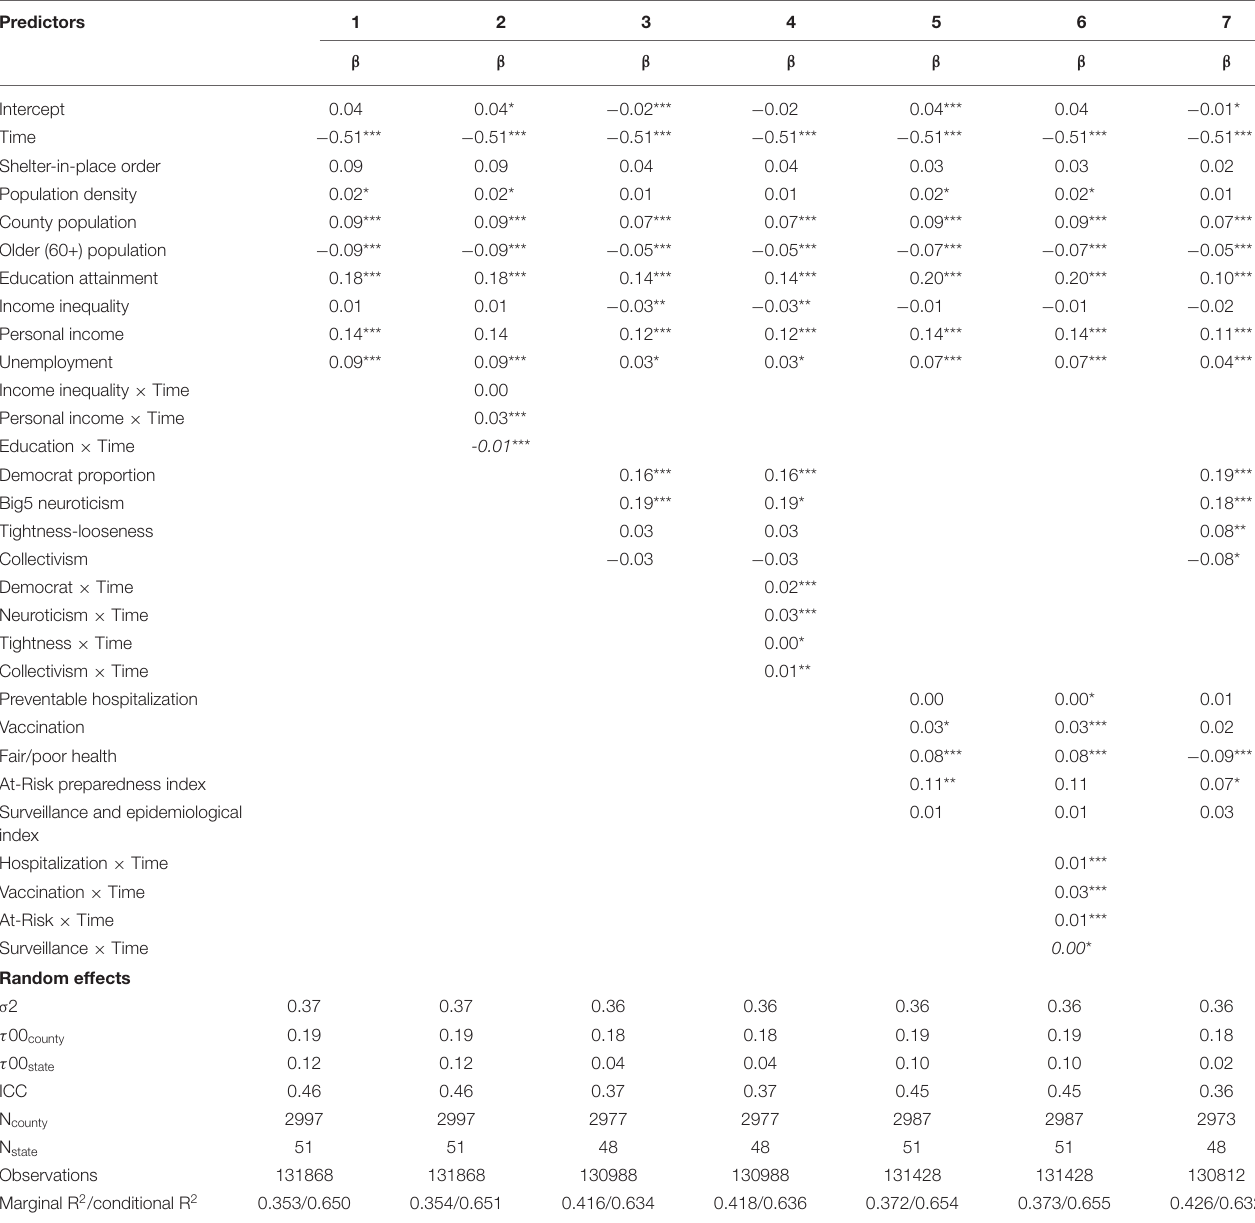
TABLE 4 | Reduction in Distance Mobility (From April 13 to May 24, 2020).